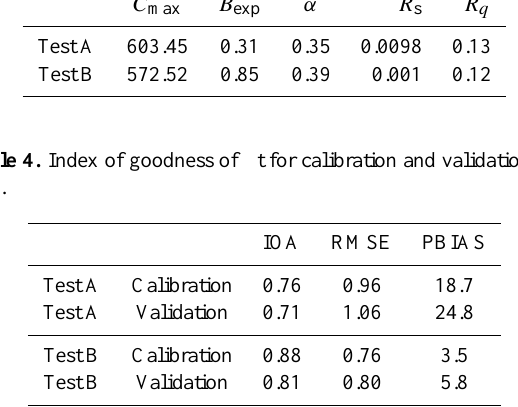
Fig. 2. The Little Washita river basin, Oklahoma (USA).